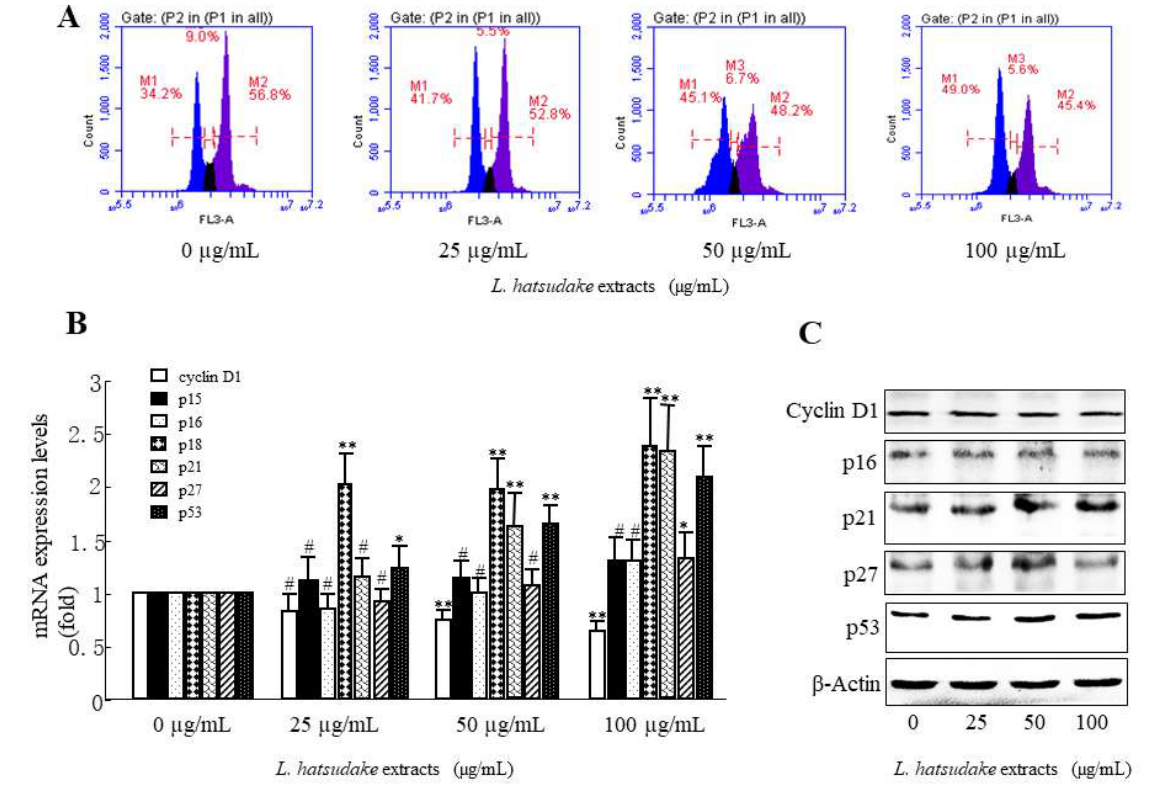
Figure 4. The effect of L. hatsudake extracts on the cell cycle, CDKIs and cyclin D1 in HCT116 cancer cells. ( A ) The effect of phenolic acids on the cell cycle of HCT116 cancer cells. ( B ) cyclin D1 and CDKI mRNA expressions; ( C ) cyclin D1 and CDKI protein expressions; *: p < 0.05; **: p < 0.01; #: p >